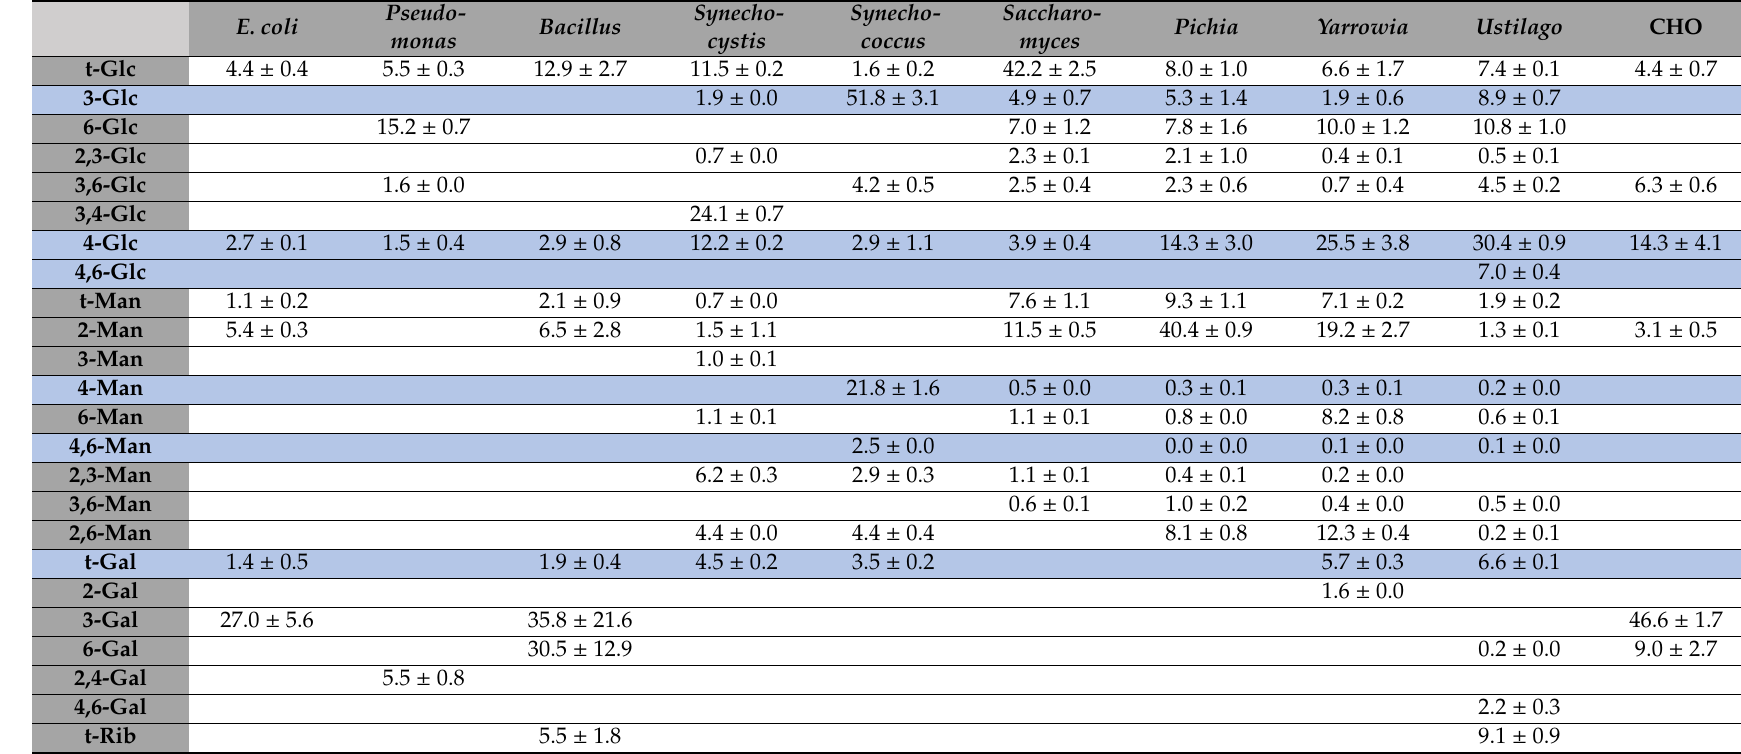
Table 2. Glycosidic linkage analysis of isolated extracellular matrices from various organisms. Organisms were grown as described in Supplemental Materials and Methods and used to determine the composition of the alcohol-insoluble residue (AIR). Shown is the percentage of the total ion chromatogram peak area of the corresponding partially methylated, acetylated alditol representing the linked sugar. Highlighted in blue are glycosyl-moieties that also represent a glycosyl-linkage present in a plant polysaccharide: 3-Glc—mixed-linkage glucan, callose; 4-Glc—starch, cellulose, xyloglucan, glucomannan; 4,6-Glc—starch, cellulose,